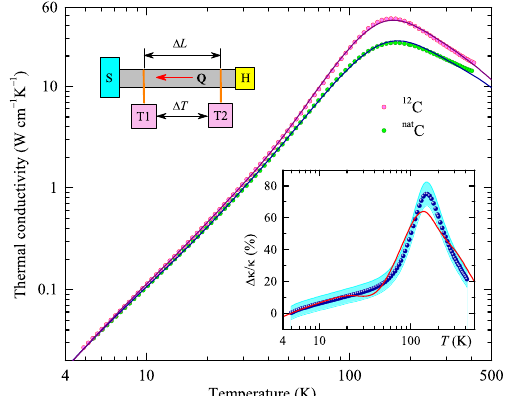
Figure 1. Thermal conductivity as a function of temperature for diamond samples with different iso- topic compositions: Symbols are experimental data for nat C (green circles) and 12 C (pink circles). The error bars are smaller than the symbols size. The right-hand inset shows ∆ κ / κ = κ ( 12 C ) / κ ( nat C ) − 1 vs. temperature: Symbols are experimental data; the cyan shaded area indicates the uncertainty in experimental data. Solid lines are theoretical dependencies (see text). The left-hand inset shows geometry of conductivity measurement (see details in the